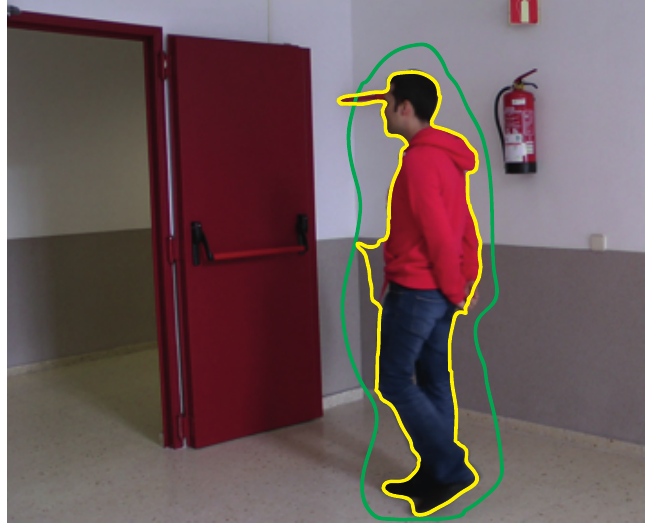
Figure 9. Example of using the active contours mode. The green line illustrates the initial contour. The yellow line shows the final